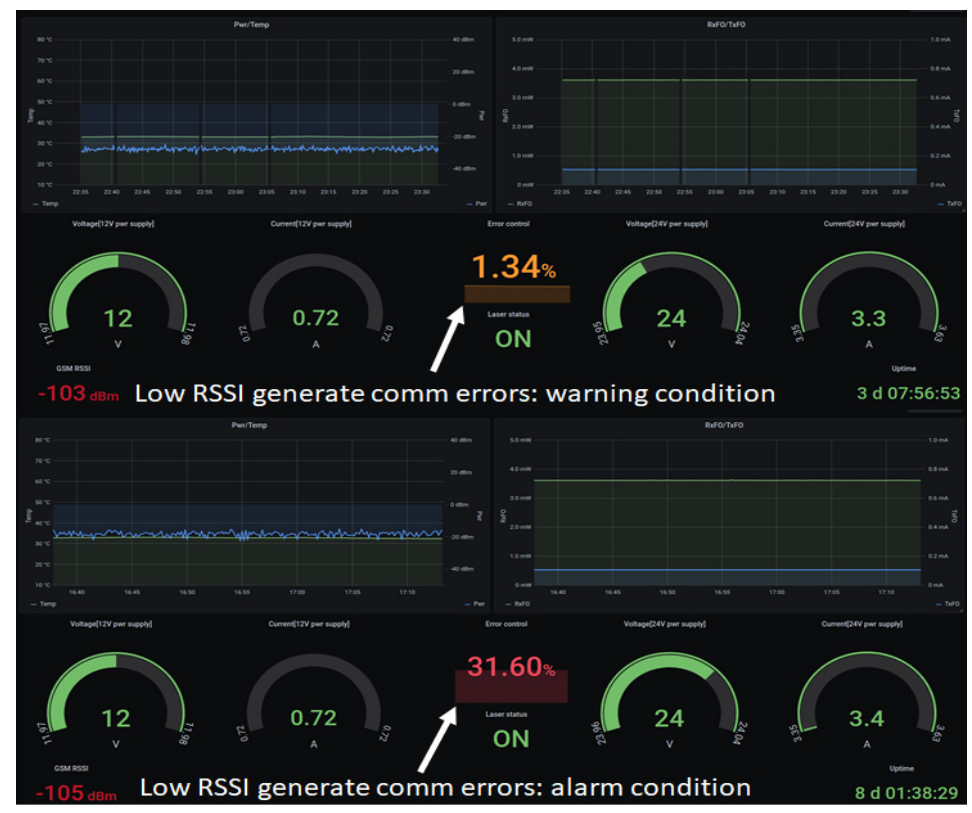
Figure 12. Error control with warning and alarm